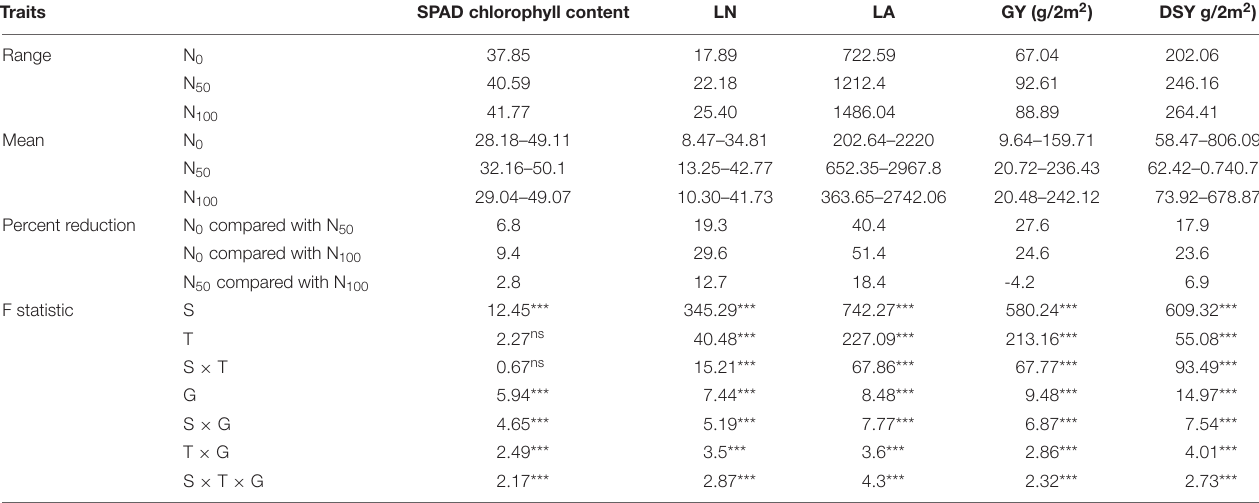
TABLE 1 | Summary statistics and ANOVA results from three seasons pooled data for physiological and agronomic traits under three N levels. Traits SPAD chlorophyll content LN LA GY (g/2m 2